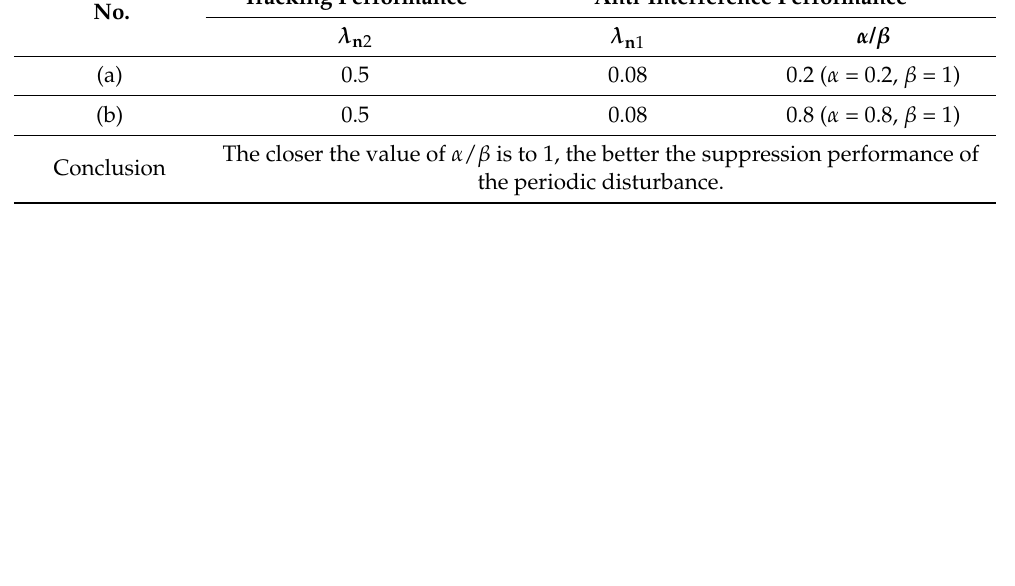
Table 7. Two schemes and conclusions of periodic vibration of drivetrain.